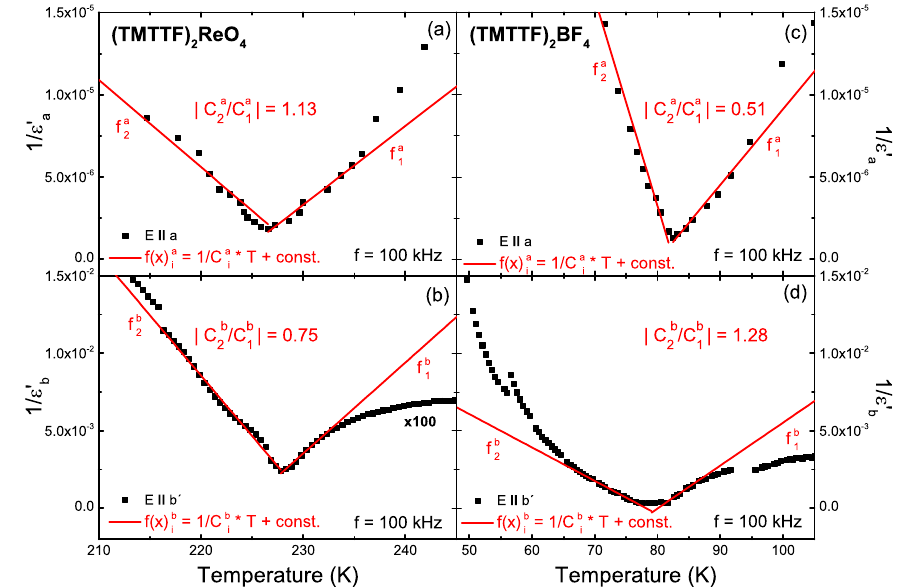
( T ) for (a,c) b (cid:48) ( T ) is b (cid:48)